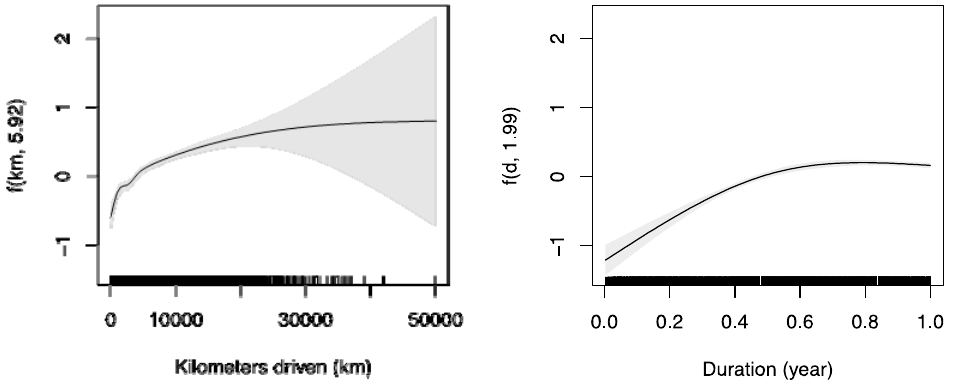
)(ˆ kmf on the left and )(ˆ df on the right for claims at fault with property Figure 6. Model 1, ˆ f 1 ( km ) on the left and ˆ f 2 ( d ) on the right for claims at fault with property damage Figure 6. Model 1, 2 1 ( nb damage ( nb 1).